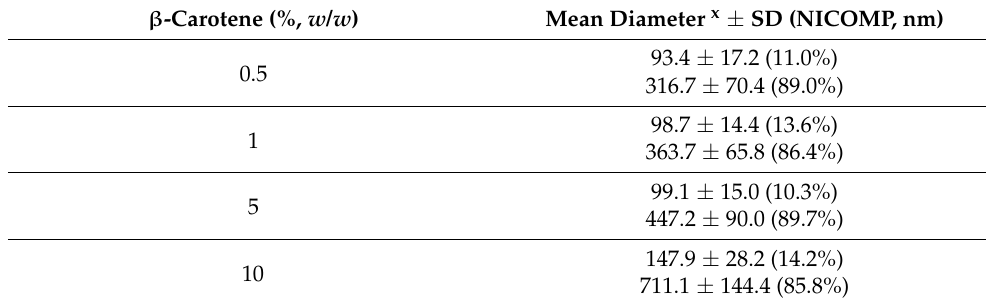
Table 6. Mean particle size of SLN loaded with different percentages of β -carotene.